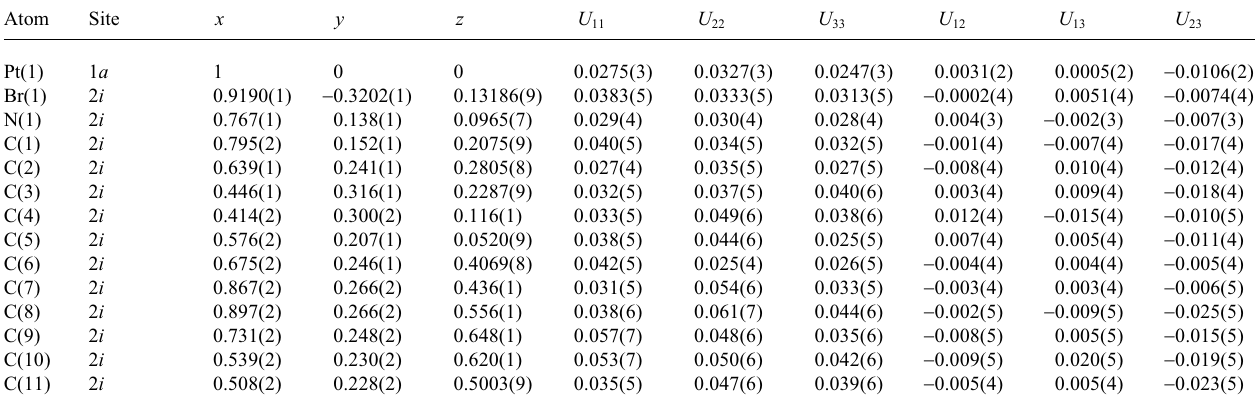
Table 3. Atomic coordinates and displacement parameters (in Å 2 )